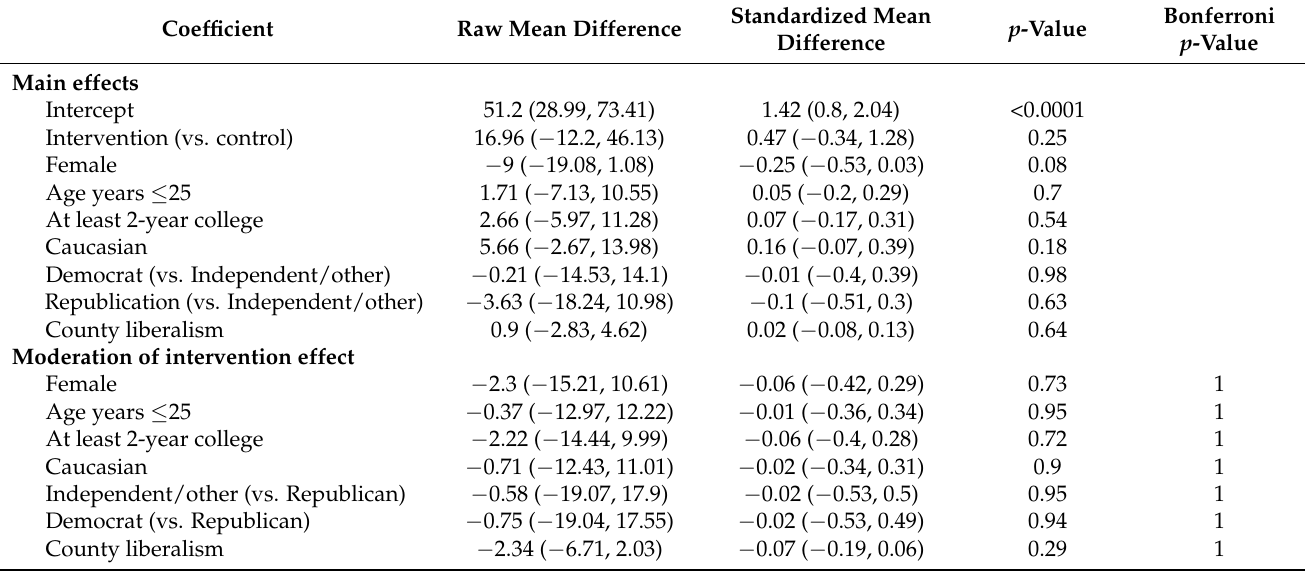
Table 3. For Study 1, estimated moderation by baseline demographic variables of the intervention’s effect on the primary outcome (total MAP consumption). Raw mean differences represent ounces consumed over the past week. Main effects represent differences in average consumption by the demographic variables. Effect modification estimates represent differ- ences in intervention effectiveness for each demographic variable, with negative values representing greater effectiveness (i.e., greater reductions in consumption). Brackets are 95% confidence intervals that do not correct for multiple testing. “Politically neutral”: Independent or “Other/I don’t know”. “County liberalism” represents a 10-percentage point higher proportion of votes cast for Democratic presidential candidates in the participant’s